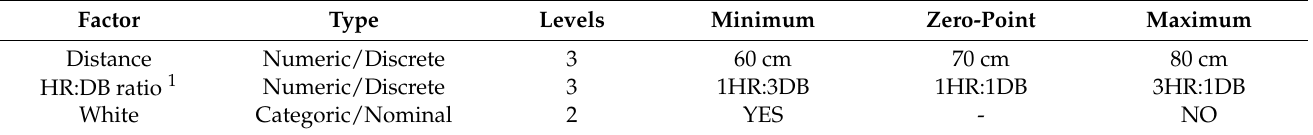
Table 5. Independent variables used for the statistical